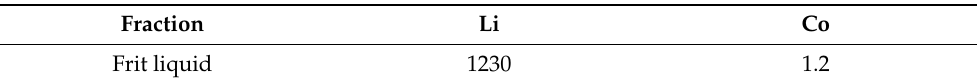
Table 4. Results from the frit liquid of the gas scrubber after suction of the exhaust gas in Design 2 LCO-C in mg/L. Fraction Li Co Frit liquid 1230 1.2